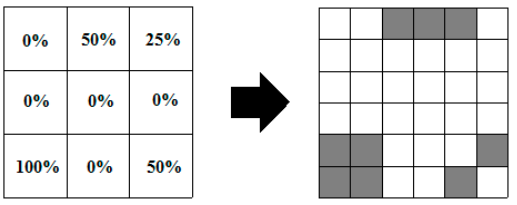
Figure 1. A raster grid of 3 × 3 coarse pixels of abundances, each divided into 2 × 2 sub-pixels. Each arrangement yields a fraction value η i , with the aim to finding the optimal